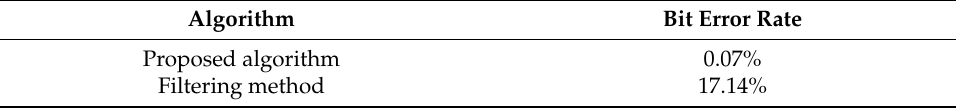
Table 3. BER of the proposed algorithm and fi ltering (strong wind).